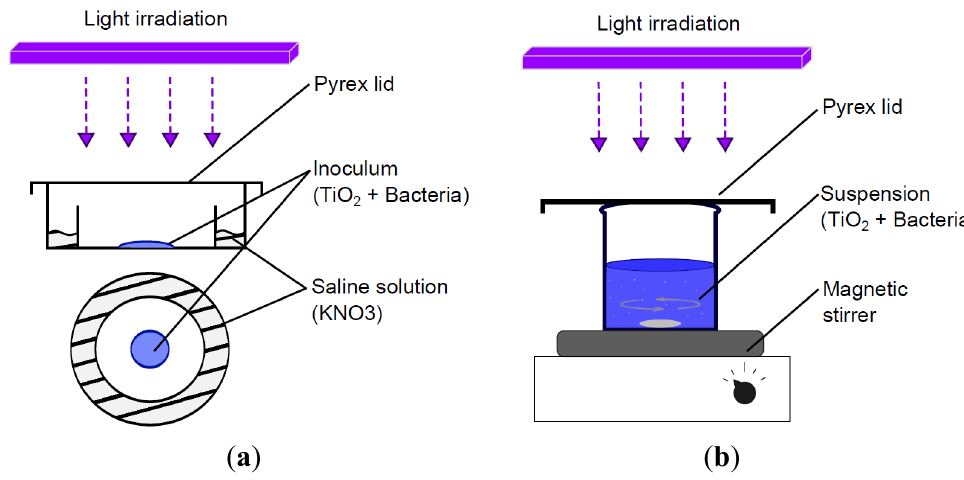
Figure 1. Schematic illustration of the deposited-drop experiments with TiO TiO semi-transparent coatings ( a ) and stirring experiment ( b 2